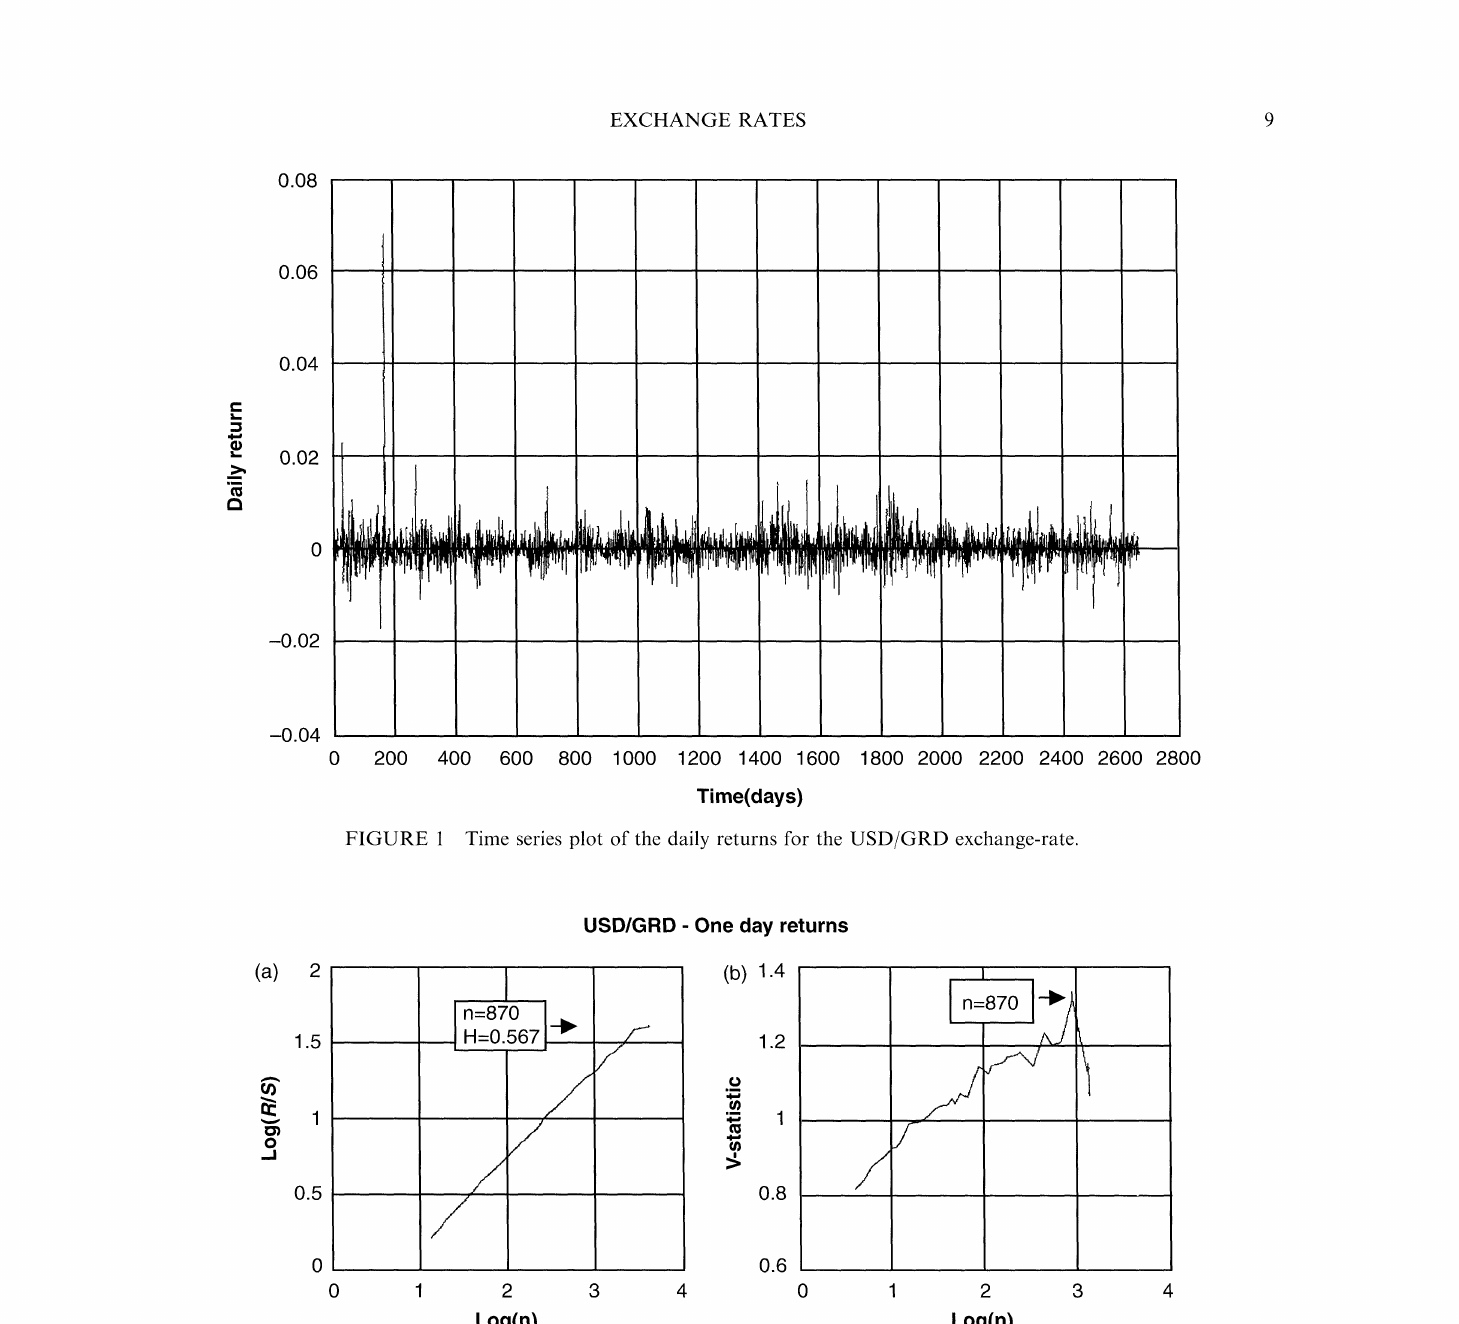
FIGURE Time series plot of the daily returns for the USD/GRD exchange-rate.